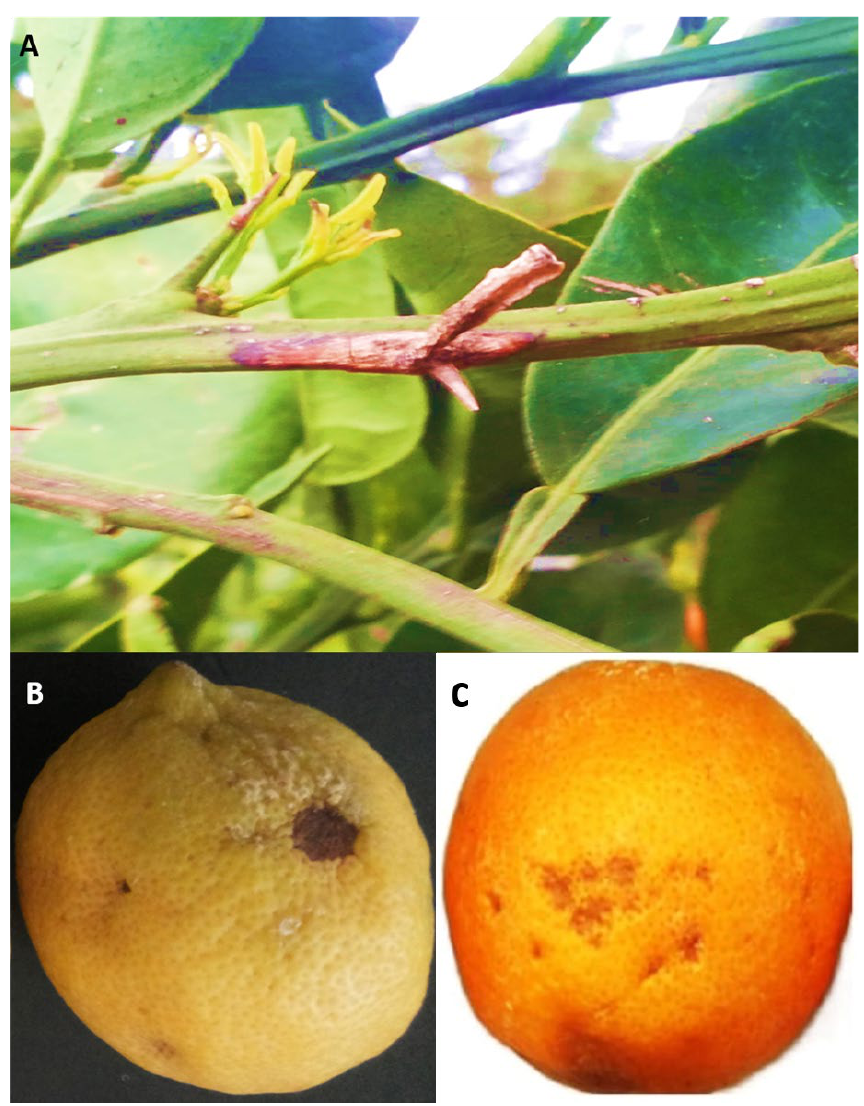
Figure 1 . Citru s blast symptom s on Orange ( Citrus sinensis L. ) (A ) and the